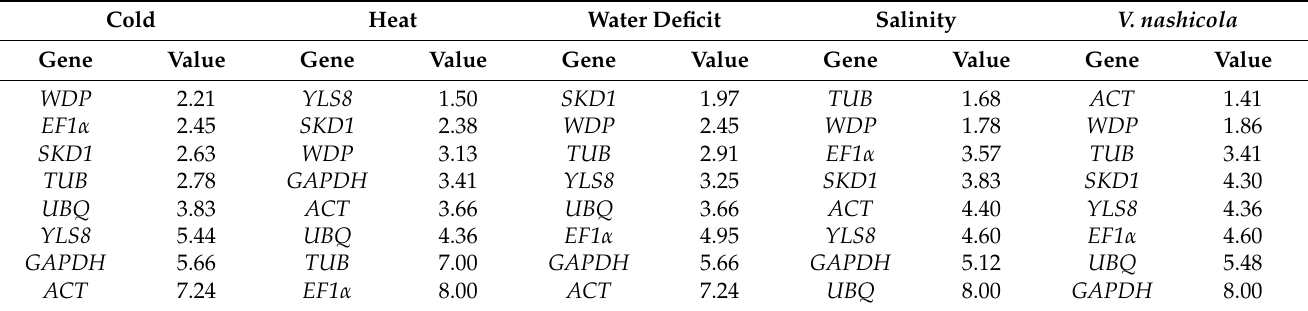
Figure 4. Analysis of reference genes for qPCR normalization using GeNorm in pear leaves under different stresses. The pairwise variation (V n/n+1 ) in the eight candidate reference genes under abiotic and biotic treatments was calculated using GeNorm software, and the optimal number of reference genes was determined using the lowest number of genes with a V n/n+1 value smaller than 0.15. Table 5. Ranking of the expression stability of the eight candidate reference genes in pears under different abiotic and biotic stresses, with Cq values being calculated in